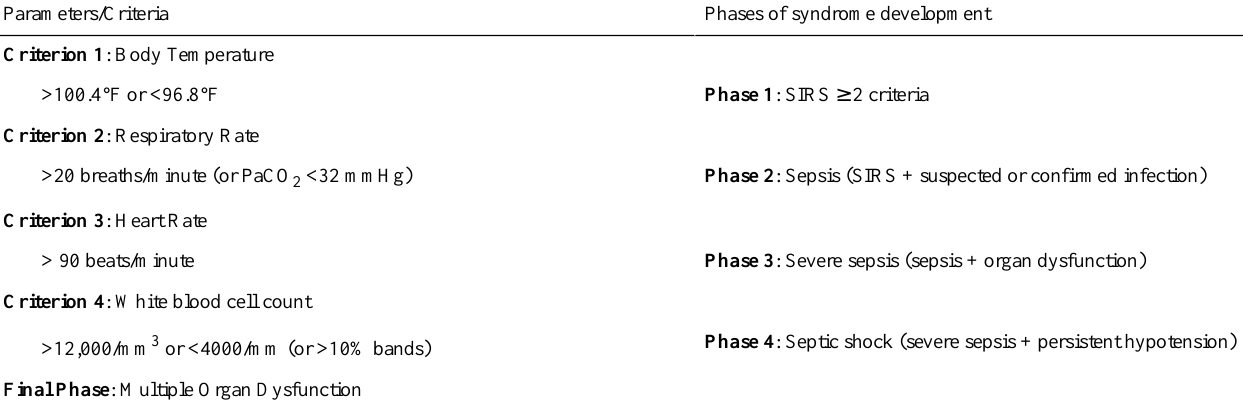
Table 1. Systemic inflammatory response syndrome (SIRS) criteria for sepsis definition.